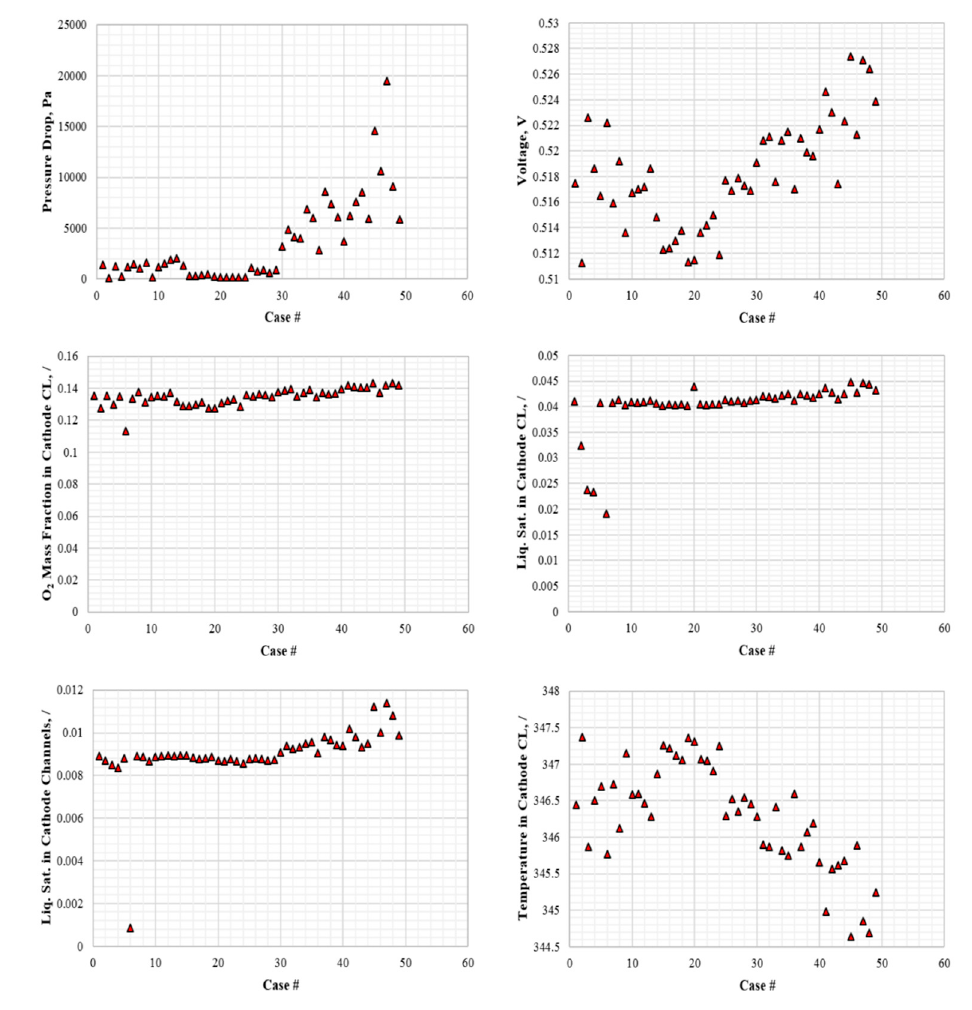
Figure 12. Operating parameters of interest at current density of 4.0 A · cm − 2 for each case.